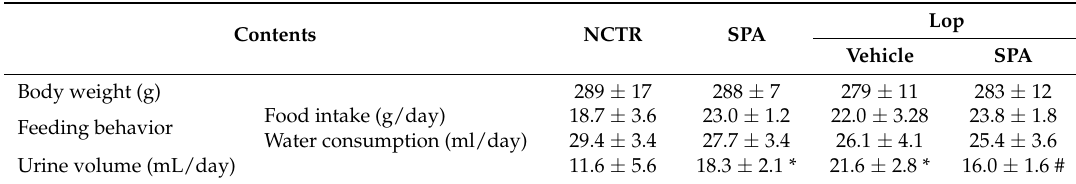
Table 1. The measurement of body weight, feeding behavior, and urine secretion in loperamide (Lop)-induced constipated Sprague Dawley (SD)